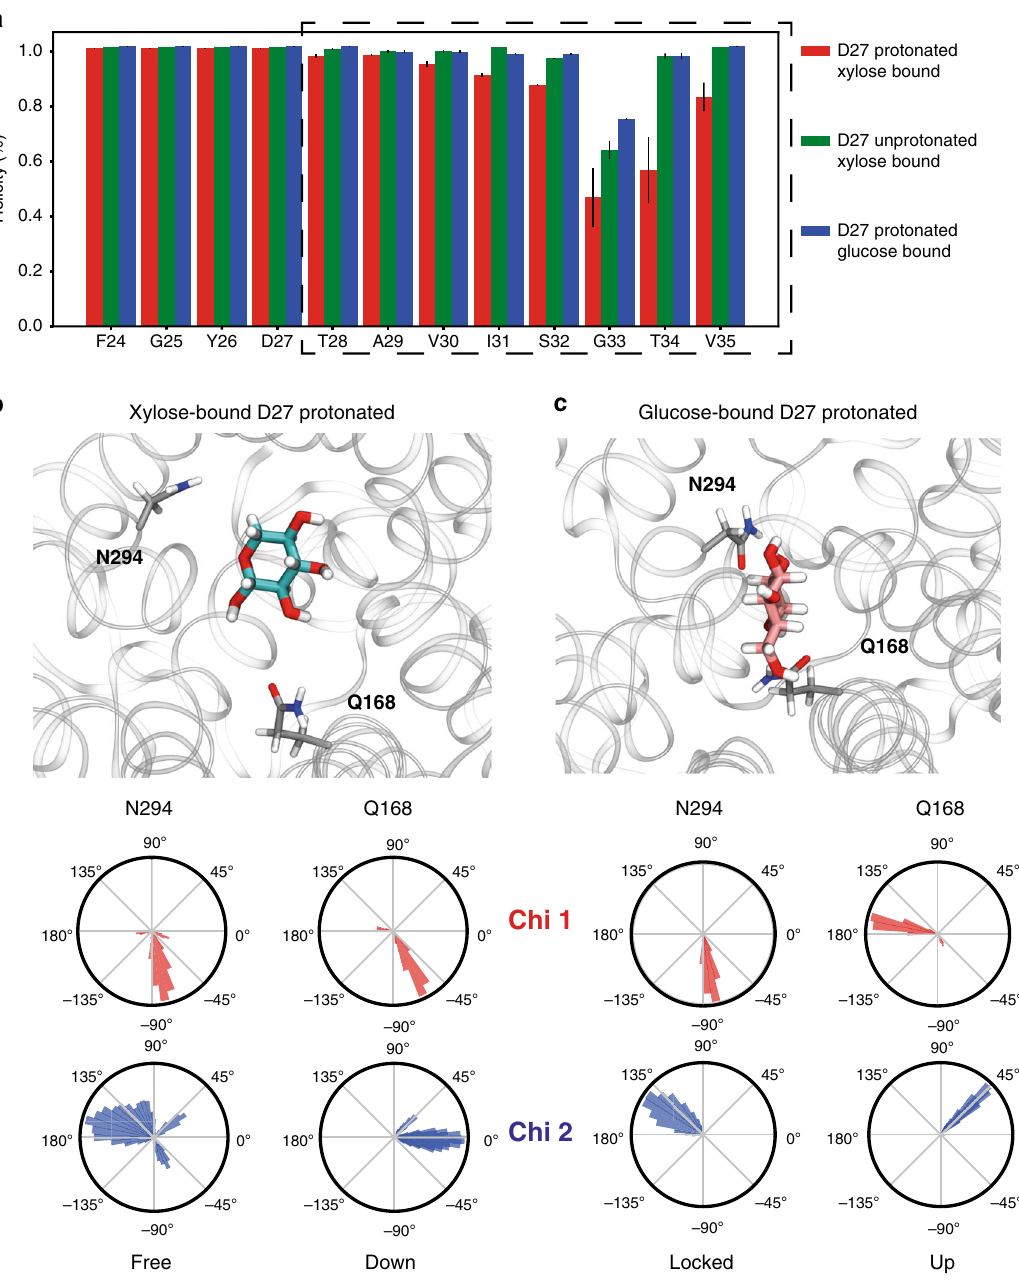
Fig. 6 Helicity content of TM1 and dihedral angle changes at substrate-binding site. a Decrease in helical content is more pronounced in the case of protonated D27 + xylose-bound case (red) than unprotonated D27 (green) or when bound to glucose (blue). Differences in the orientation of N294 and Q168 based on the Chi 1 and Chi 2 dihedral maps generated from the combined trajectory of the two replicates. Protein and ligand are rendered from an equilibrated snapshot from MD trajectory at t > 100 ns. In b , N294 is freely moving and residue Q168 is pointing down and away from xylose, whereas in c , residue N294 is locked and Q168 is pointing up and towards